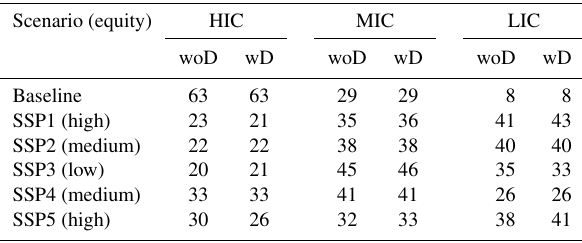
Table A1. Percentages of GWP of high-, medium- and low- income countries for reference scenarios without downscaled damage (woD) and with downscaled damage (wD) for baseline year 2000 and in 2100.